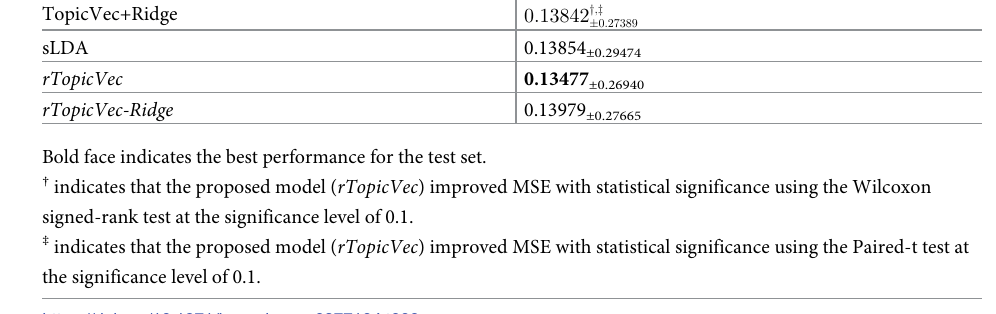
Table 6. MSE and sample standard deviation on test set of movie rating score prediction when K = 15. TopicVec+LR 0 : 13850 y ; z TopicVec+Ridge sLDA